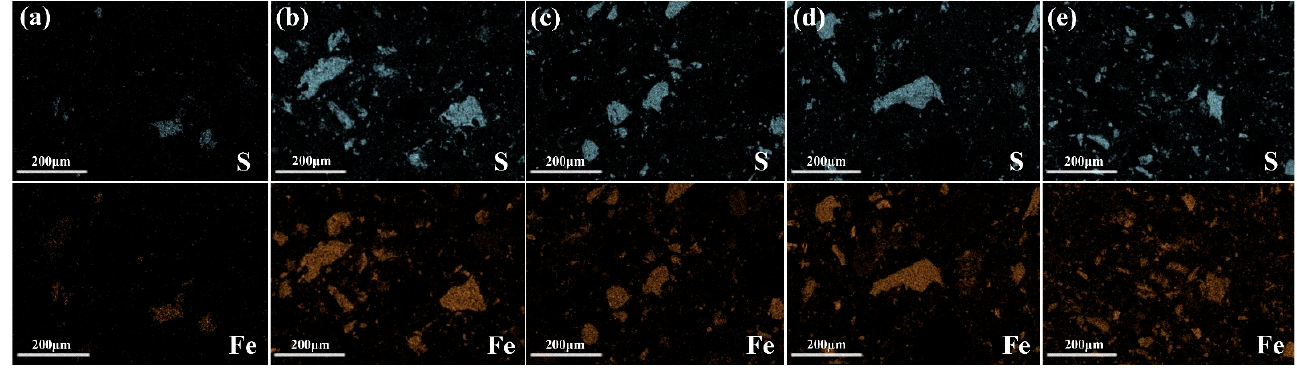
Figure 3. BSE images of 28 d MASM mortars: ( a ) M0S; ( b ) M5S; ( c ) M10S; ( d ) M13S; ( e ) M15S; ( f ) M20S.